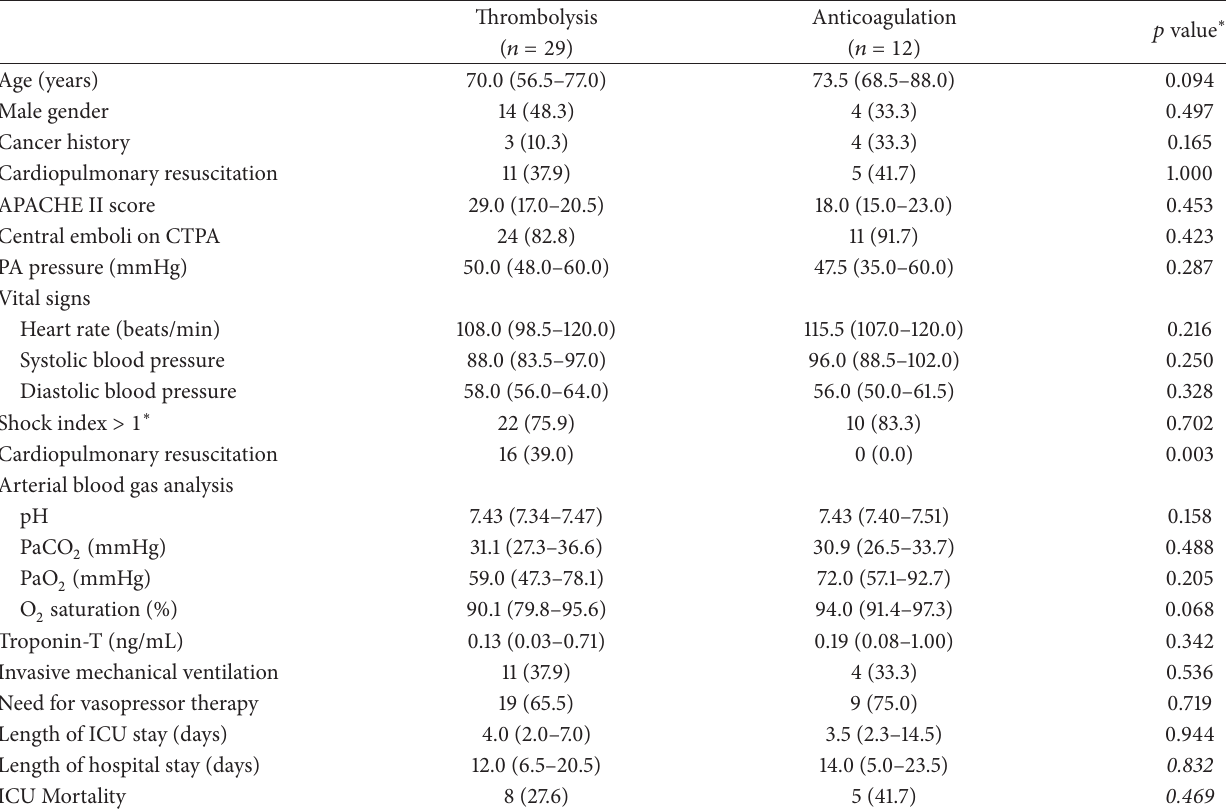
Table 4: Comparison of group 1 patients according to therapy for pulmonary embolism.